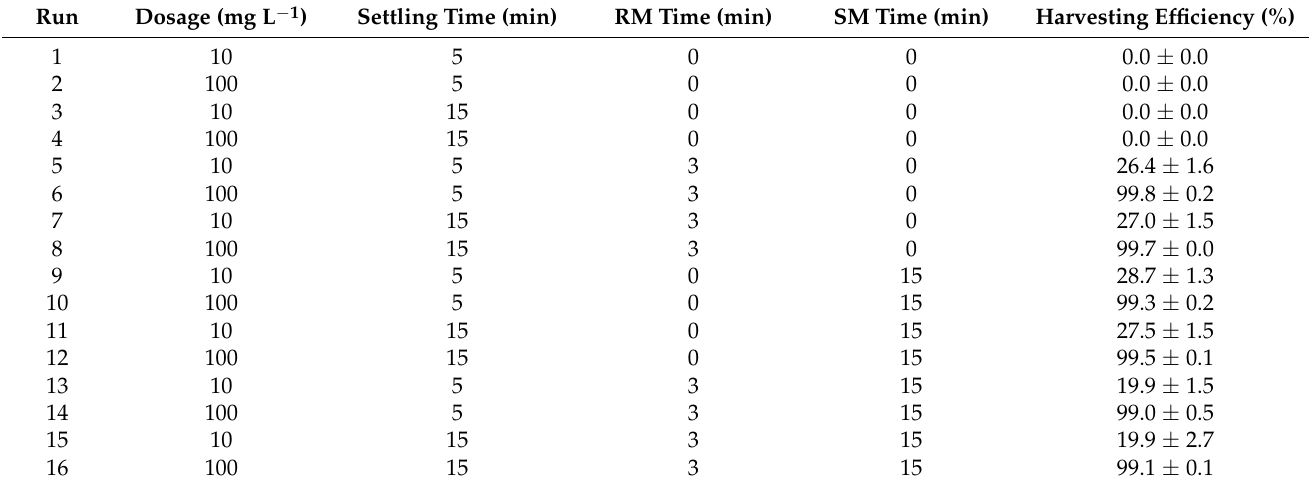
Table 4. The harvesting efficiency obtained in the 2 4 full factorial design experiment.